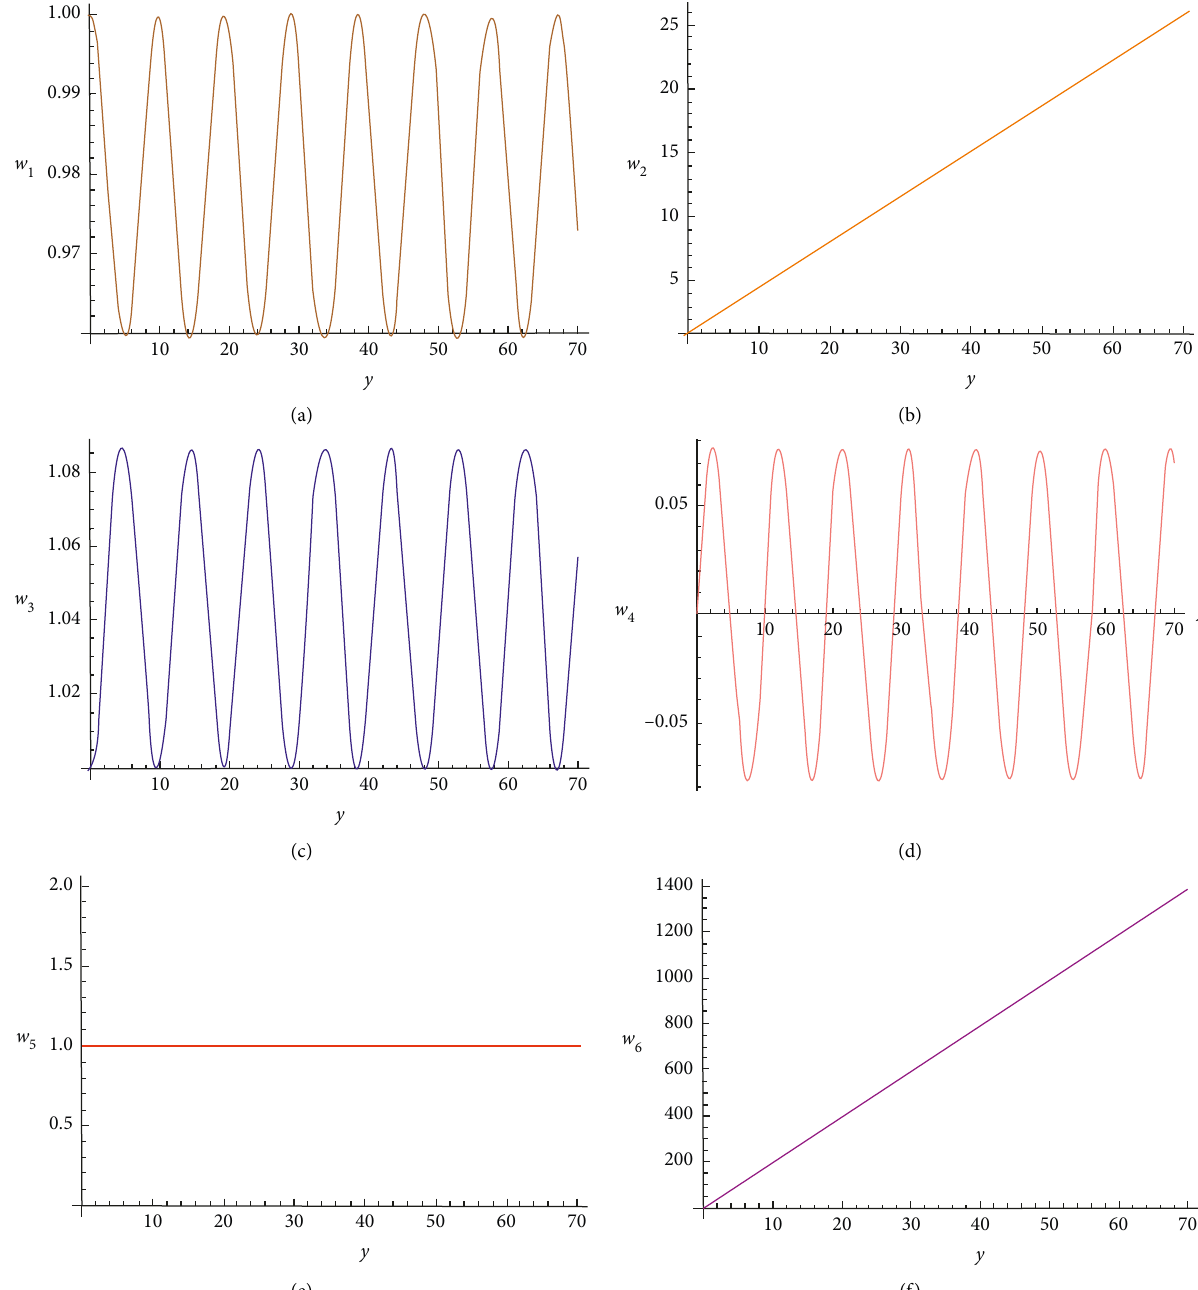
Figure 3: 2D analysis of CVs w